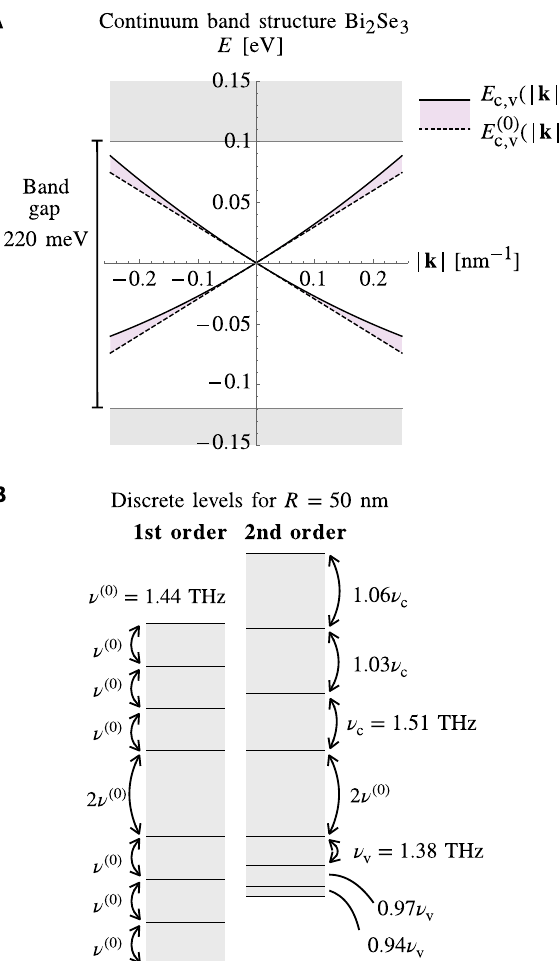
Se Figure 3: k.p breakdown: (A) continuum band structure for Bi 2 3 with Dirac cone in the band gap ( = 220 meV [61]). Band structure up to and including k 2 terms (solid black line), E ( | k | ) (for the c , v conduction and valence band sections of the Dirac cone, respectively), deviates from the linear k ⋅ p approximation (dotted black line), E (0) ( | k | ). The disparity increases away from the Gamma c,v point. (B) For a R = 50 nm nanoparticle, discretised energy levels are expected. In the linear approximation, transition frequency 𝜈 (0) = 1 . 44 THz, whereas when taking into account the k 2 term, sequential transitions away from the Γ -point deviate